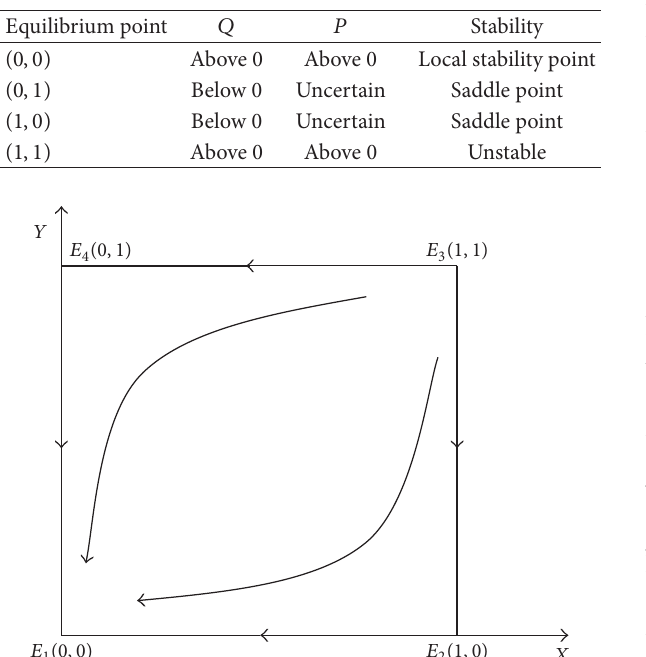
Table 3: The results of the other three